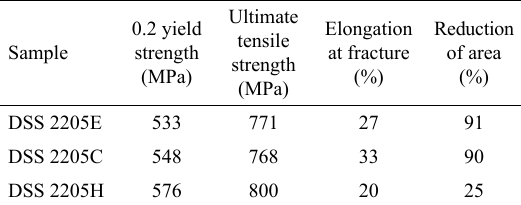
Table 3. Mechanical properties of hydrogenated and non-hydrogenated samples.